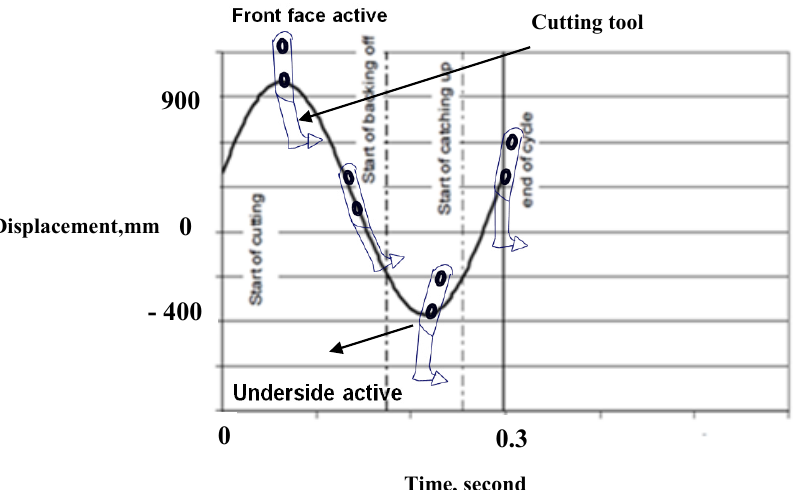
Figure 1: Tool trajectory and orientation for vibratory tillage tool